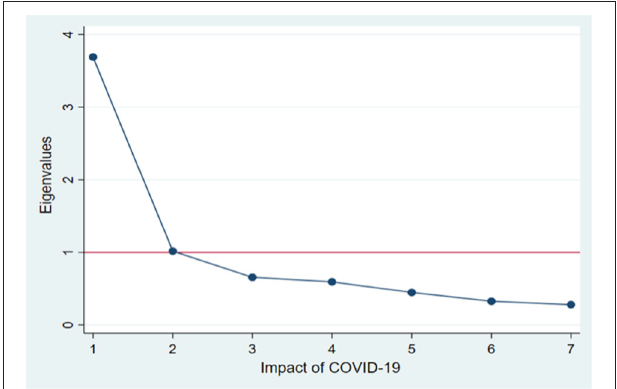
FIGURE 1 | Scree plot of eigenvalues after Principal Component